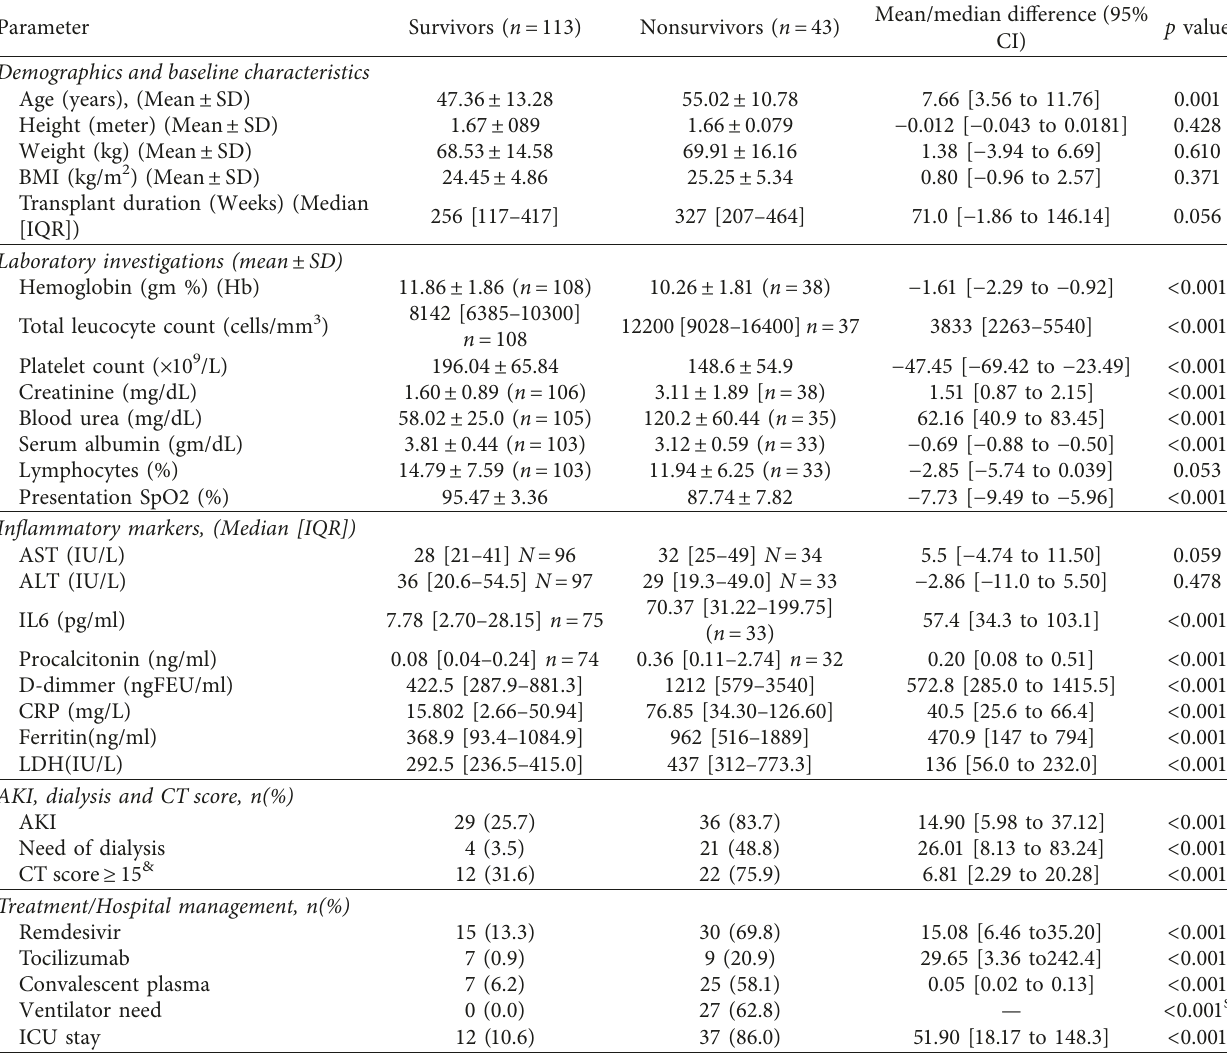
Table 5: Association between mortality and demographics, laboratory investigations, CTscan, and treatment options of KTRs with COVID- 19.